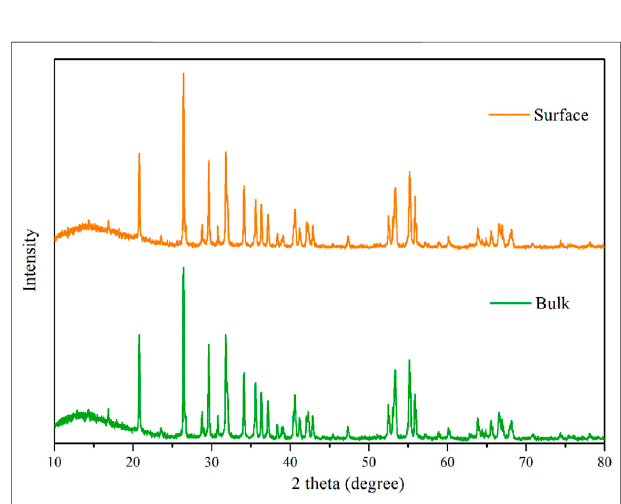
FIGURE 3 | XRD patterns of the surface and interior of the REM